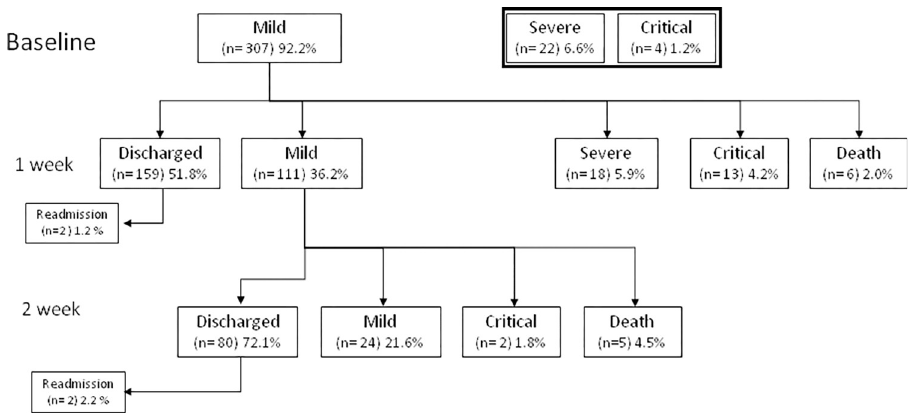
Fig 2. Flow chart of the evolution during